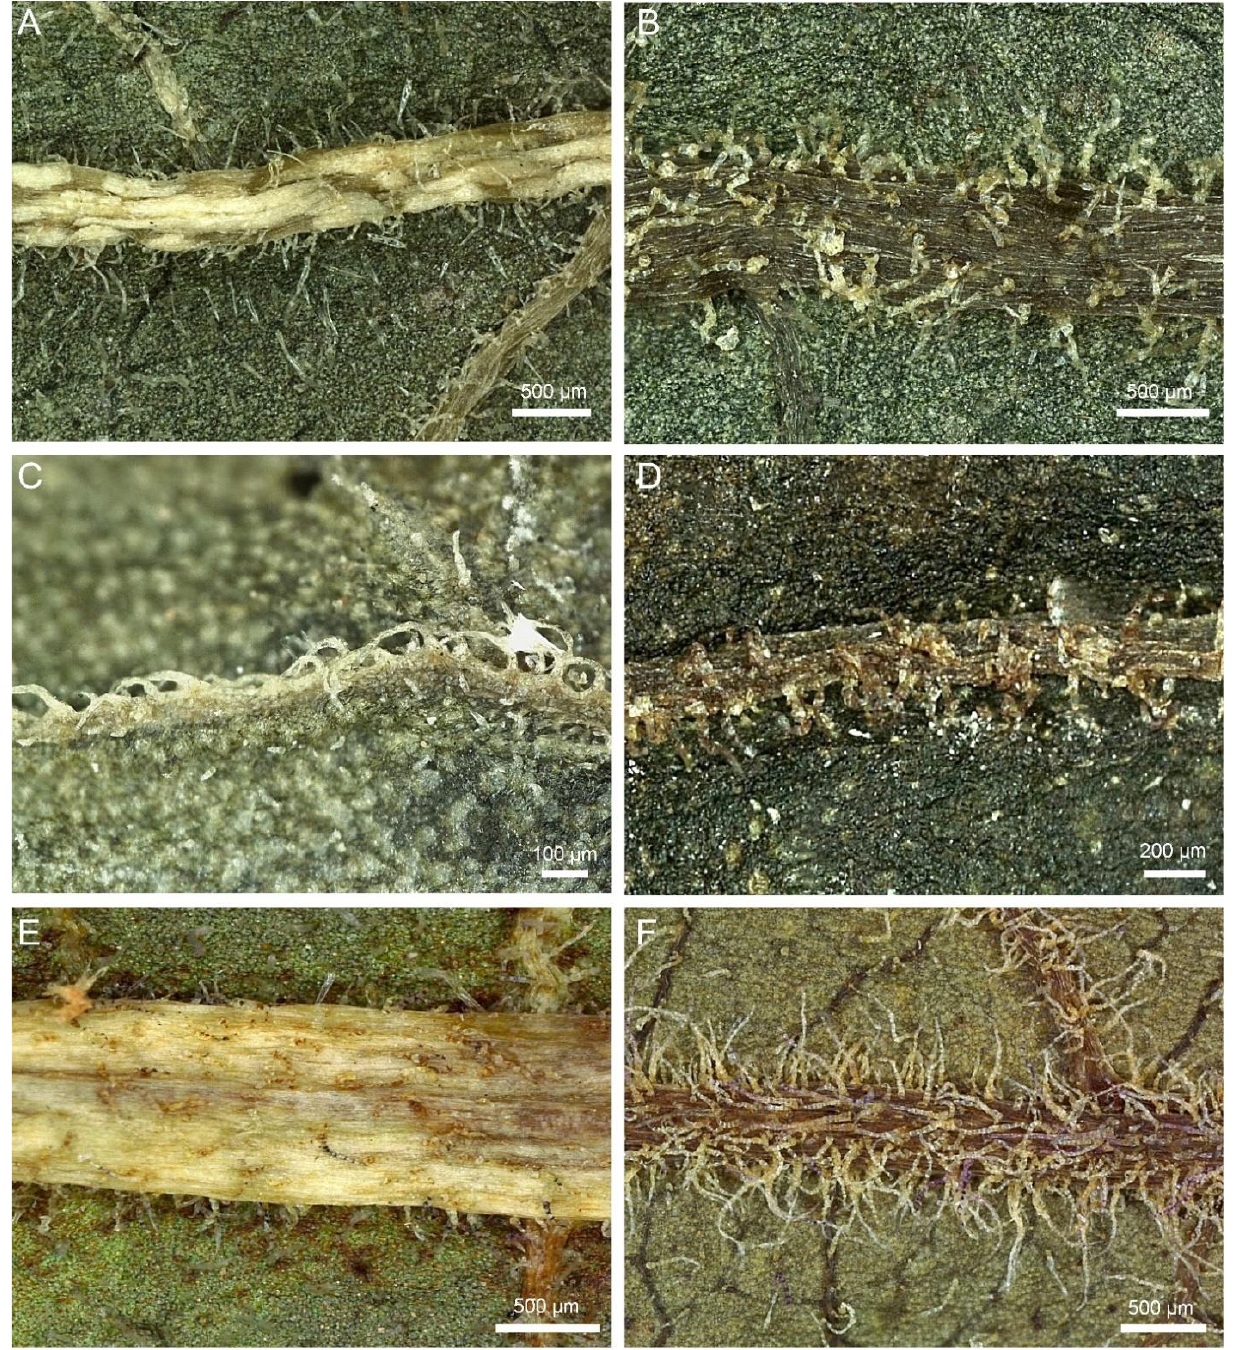
Figure 1. Trichomes ’ diversity on the midvein in leaves of Causonis . ( A ) Abaxial leaf surface of C. timoriensis var . mekongensis with straight hairs (CPG32937) . ( B ) Abaxial leaf surface of C. fugongensis with curved hairs. ( C ) Adaxial leaf surface of C. trifolia with hooked hairs (CPG23885). ( D ) Adaxial leaf surface of C. fugongensis with appressed hairs. ( E ) Abaxial leaf surface of C. timoriensis var . mekongensis with pilose hairs (CPG18926) . ( F ) Abaxial leaf surface of C. mollis with villous hairs.